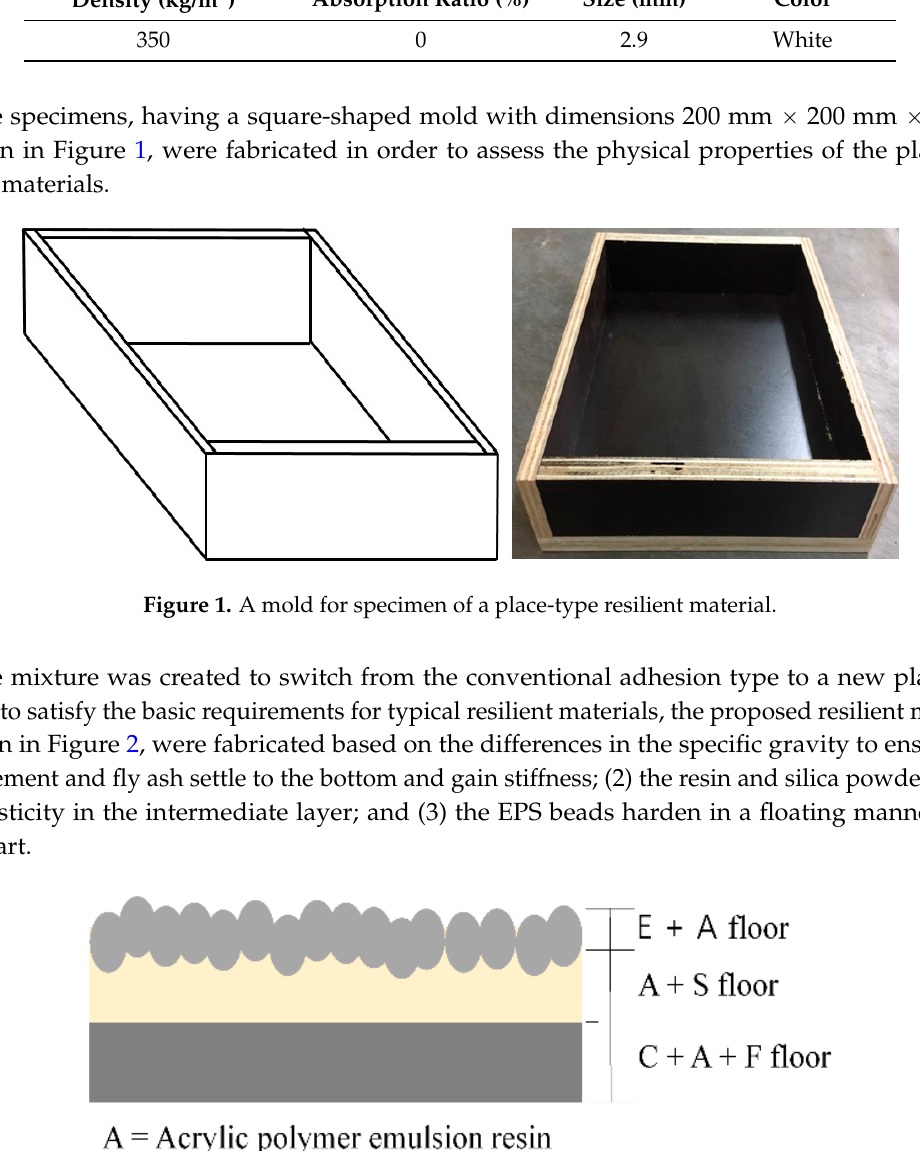
Figure 2. Schematic diagram of the place-type resilient material.